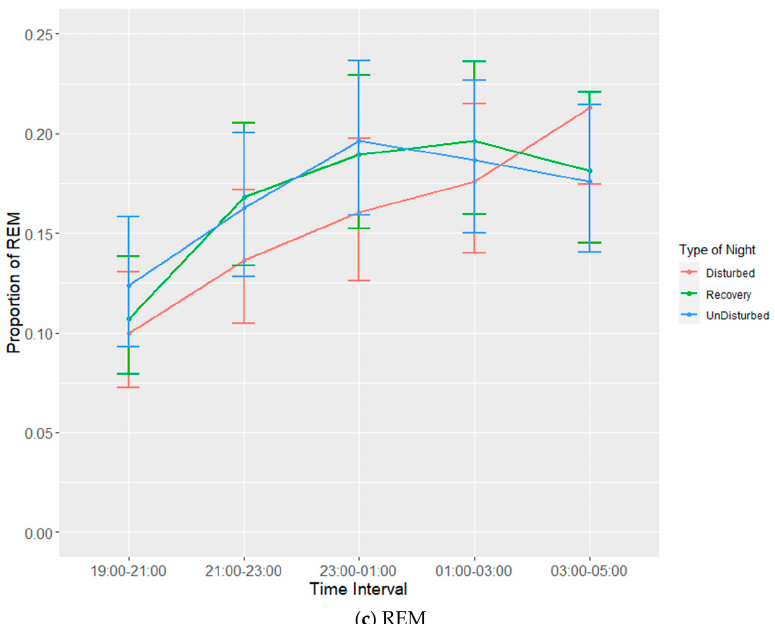
Figure 6. Effects during lights off of the interaction between time interval and three different types of night on proportions of states: ( a ) wakefulness (WAKE), ( b ) slow-wave sleep (SWS) and ( c ) rapid eye movement (REM) sleep. Values are back-transformed means ± SEs estimated from LMMs fitted to angular transformed proportions.